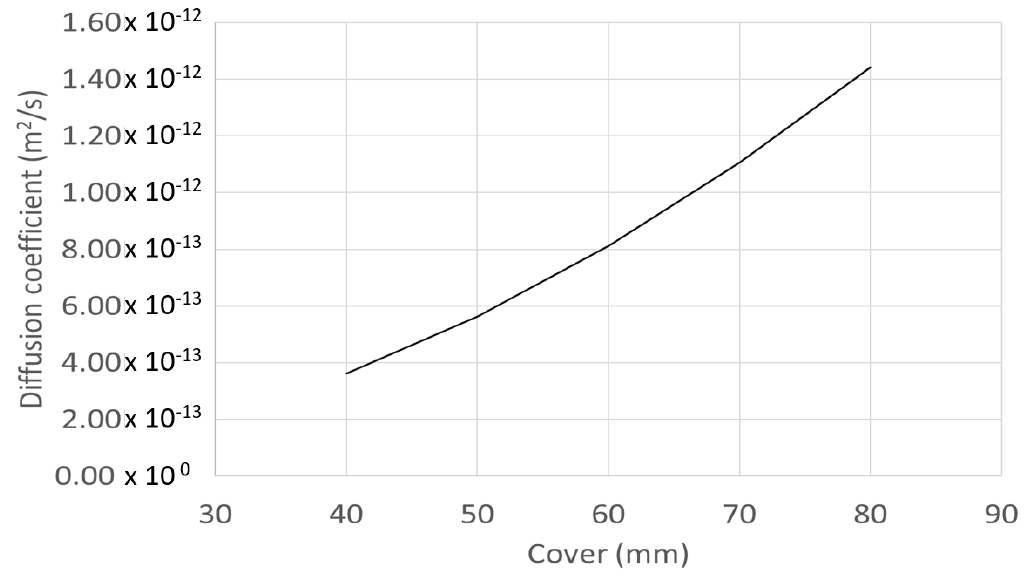
Figure 1. Example of the required diffusion coefficient for a given cover to prevent corrosion for 100 years, with a 0.4% corrosion threshold and 1% effective surface concentration.